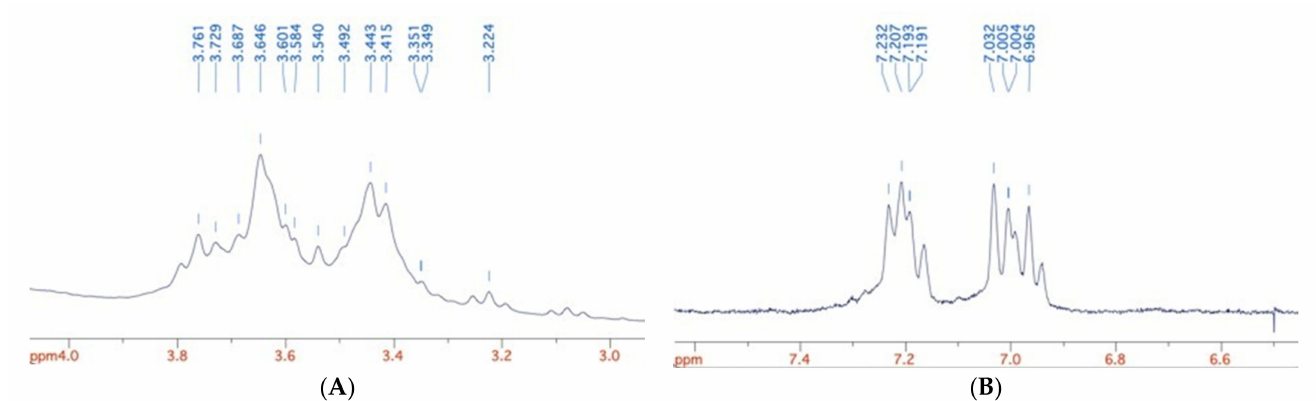
Figure 4. Qualitative composition of the formula shown by 1 H-NMR analysis with suppression of water signal. ( A ) In the chemical shift range 3–4, the presence of sugar fraction is shown. In the chemical shift range 7–8 ( B ), the signals of phenolic compounds are shown.